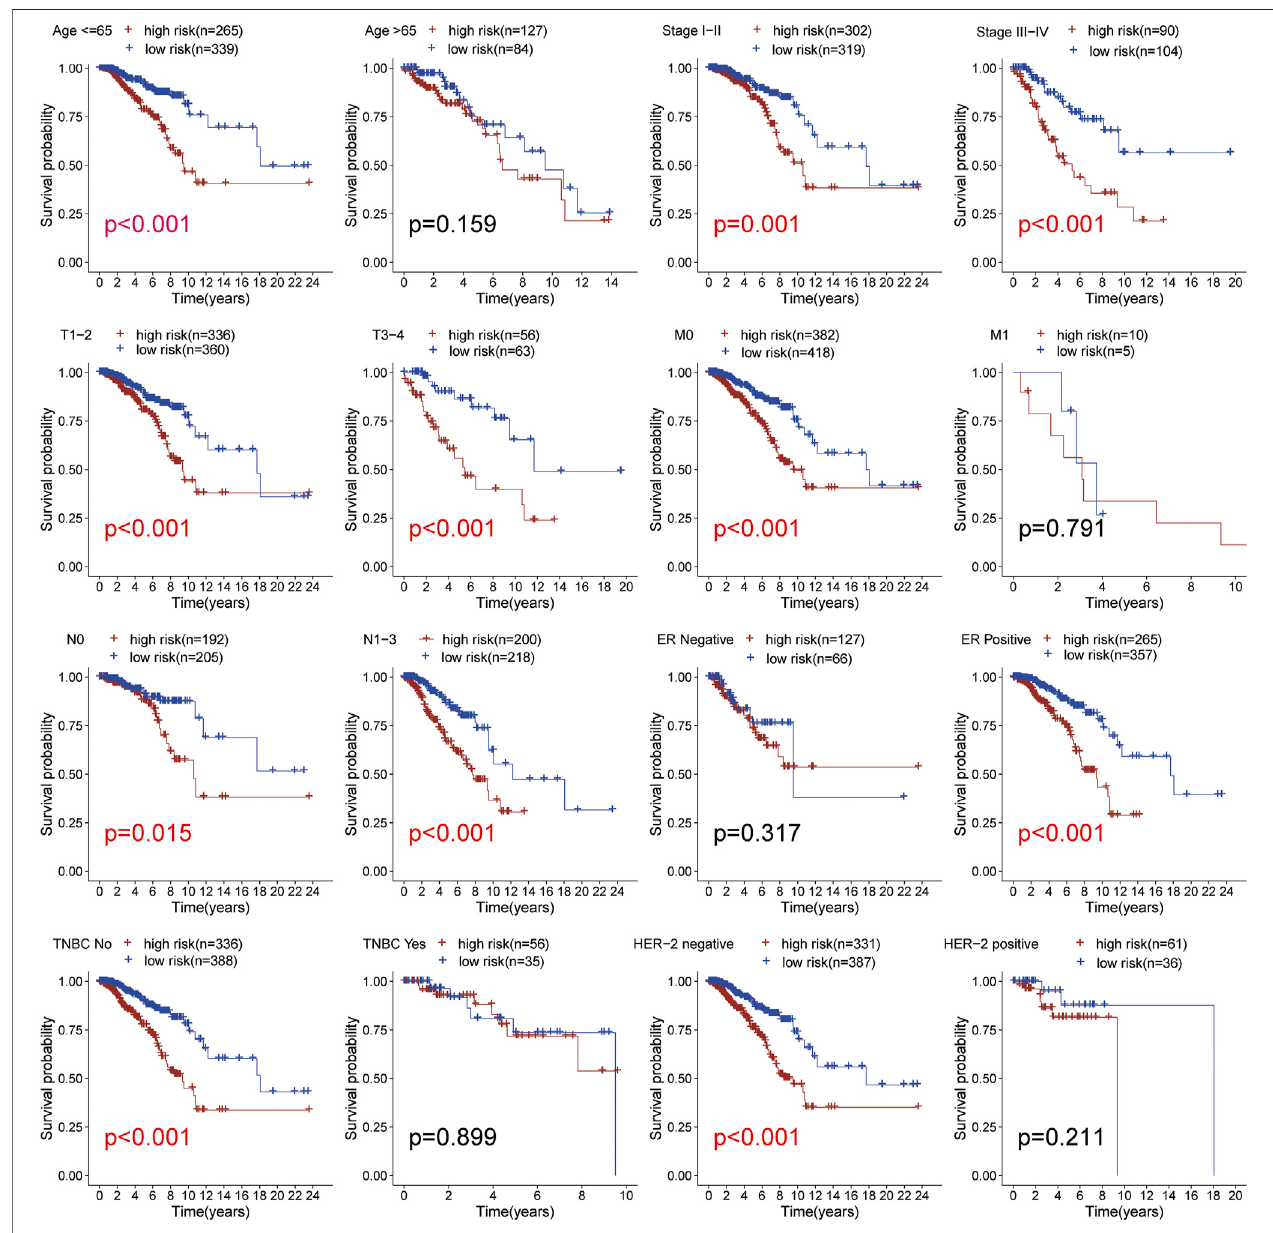
FIGURE 5 | Subgroup analysis. Kaplan-Meier survival curve analysis of patients with high-vs low-risk scores in different subgroups including age, TNM stage, ER status, HER-2 status, TNBC status. All the K-M survival analyses use log-rank tests to determine signi fi cant differences in subgroups.